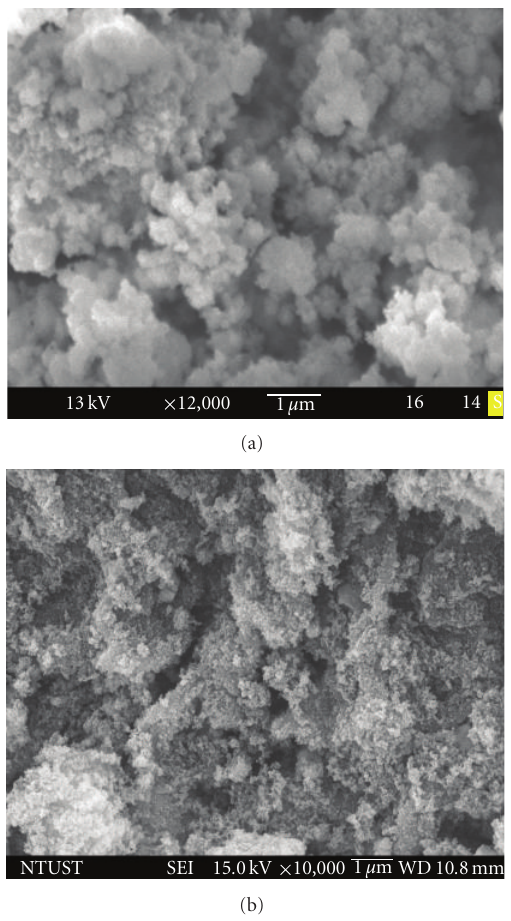
Figure 3: SEM images of (a) Fe 2 O 3 /SiO 2 and (b) Fe 2 O 3 /SiO 2 /TiO 2 . (VSM), as shown in Figure 4. The M-H plots showed the change in Ms of the particles after the incorporation of SiO 2 and TiO 2 shell. A decrease in Ms from 61.8 to 28.0